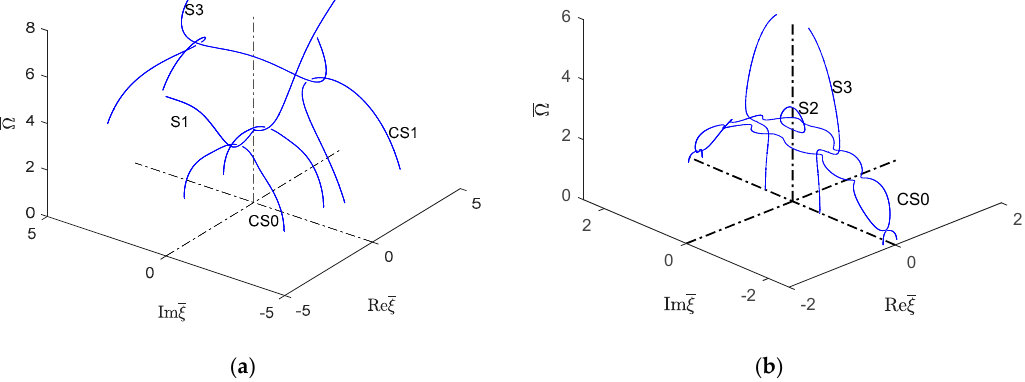
Figure 18. Real (propagating) and imaginary (evanescent) and complex wavenumber solution for the first few symmetric modes of Lamb wave type GWs for ( a ) isotropic material and ( b ) unidirectional CFRP composite.